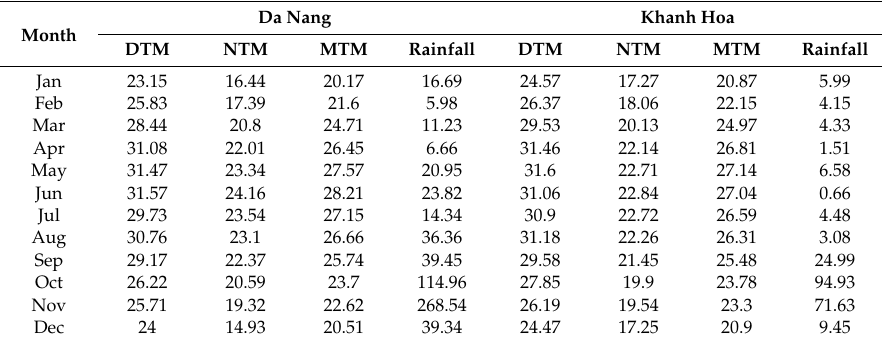
Table A1. Monthly climatic variables in Da Nang and Khanh Hoa,